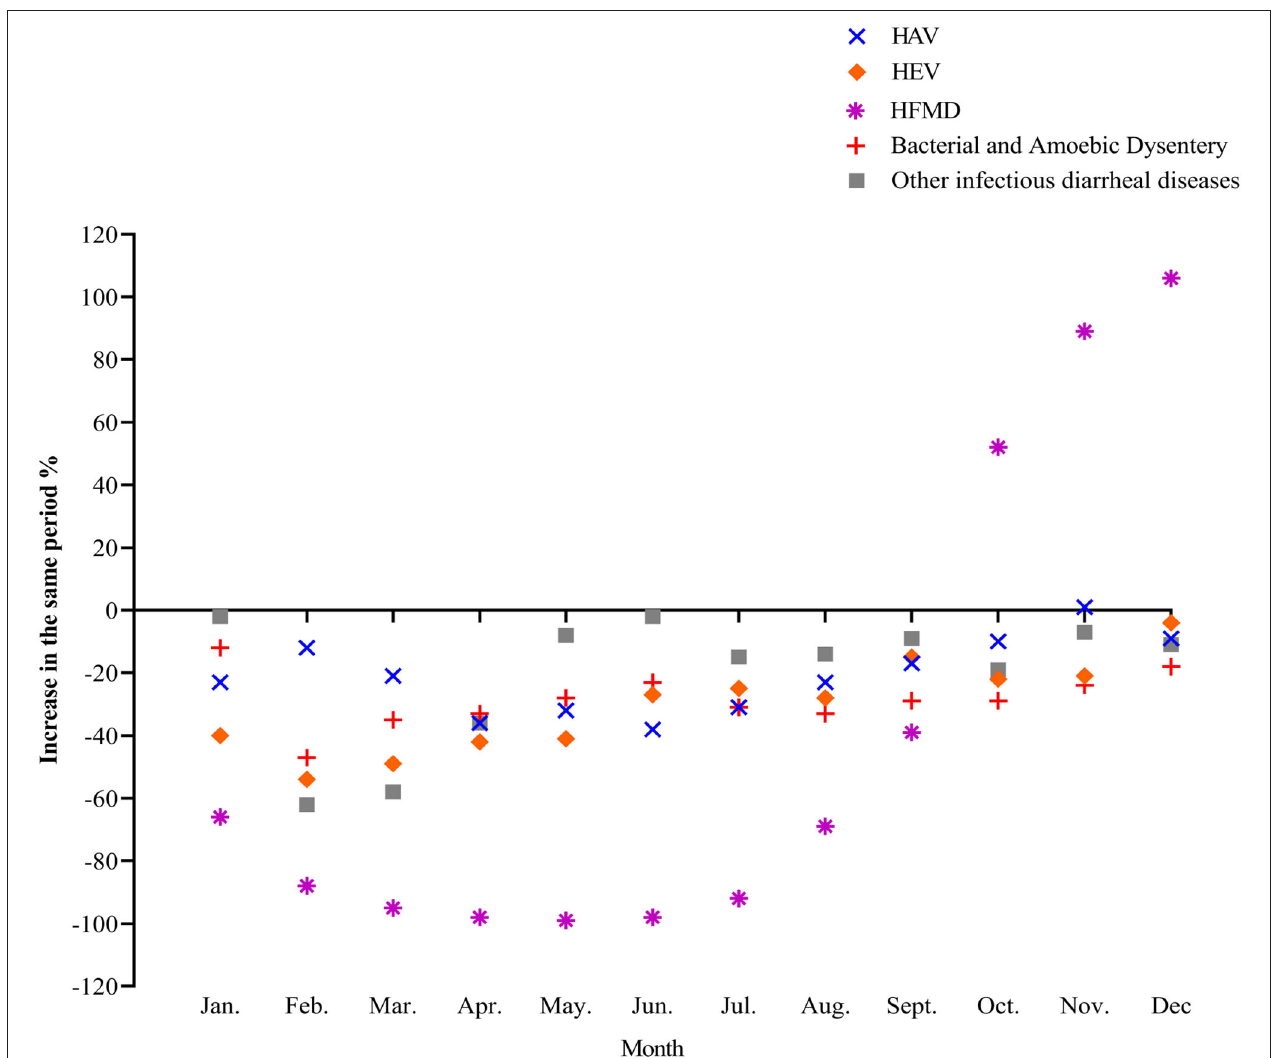
FIGURE 4 | The incidence trend of common intestinal infectious diseases in